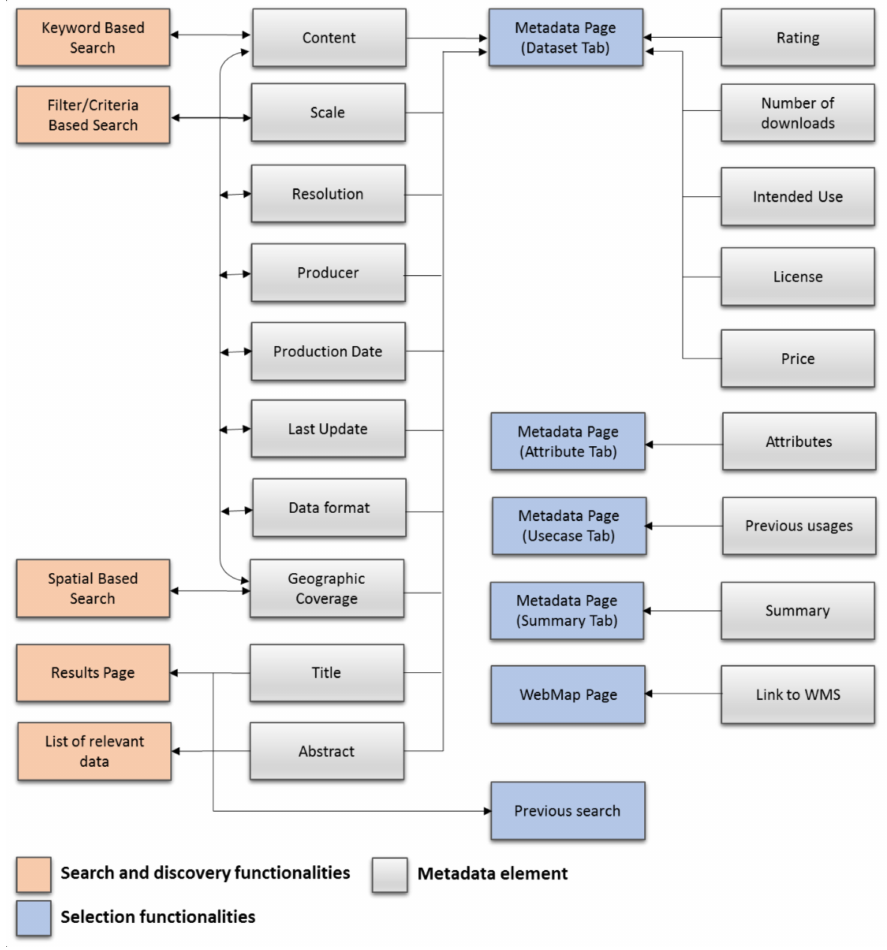
Figure 3. The relationship of metadata elements and user-interface